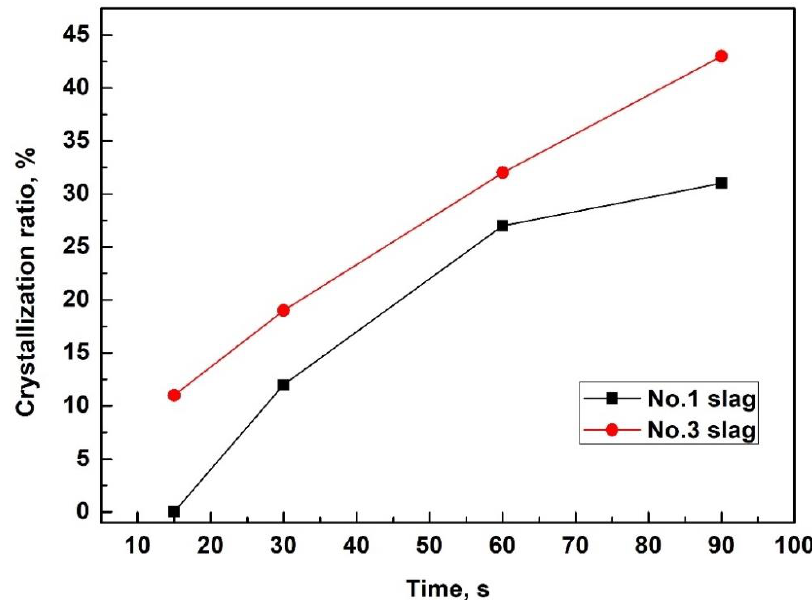
Figure 10. Crystallization ratio evolution of typical slag films solidified in molten slag at 1400 °C.